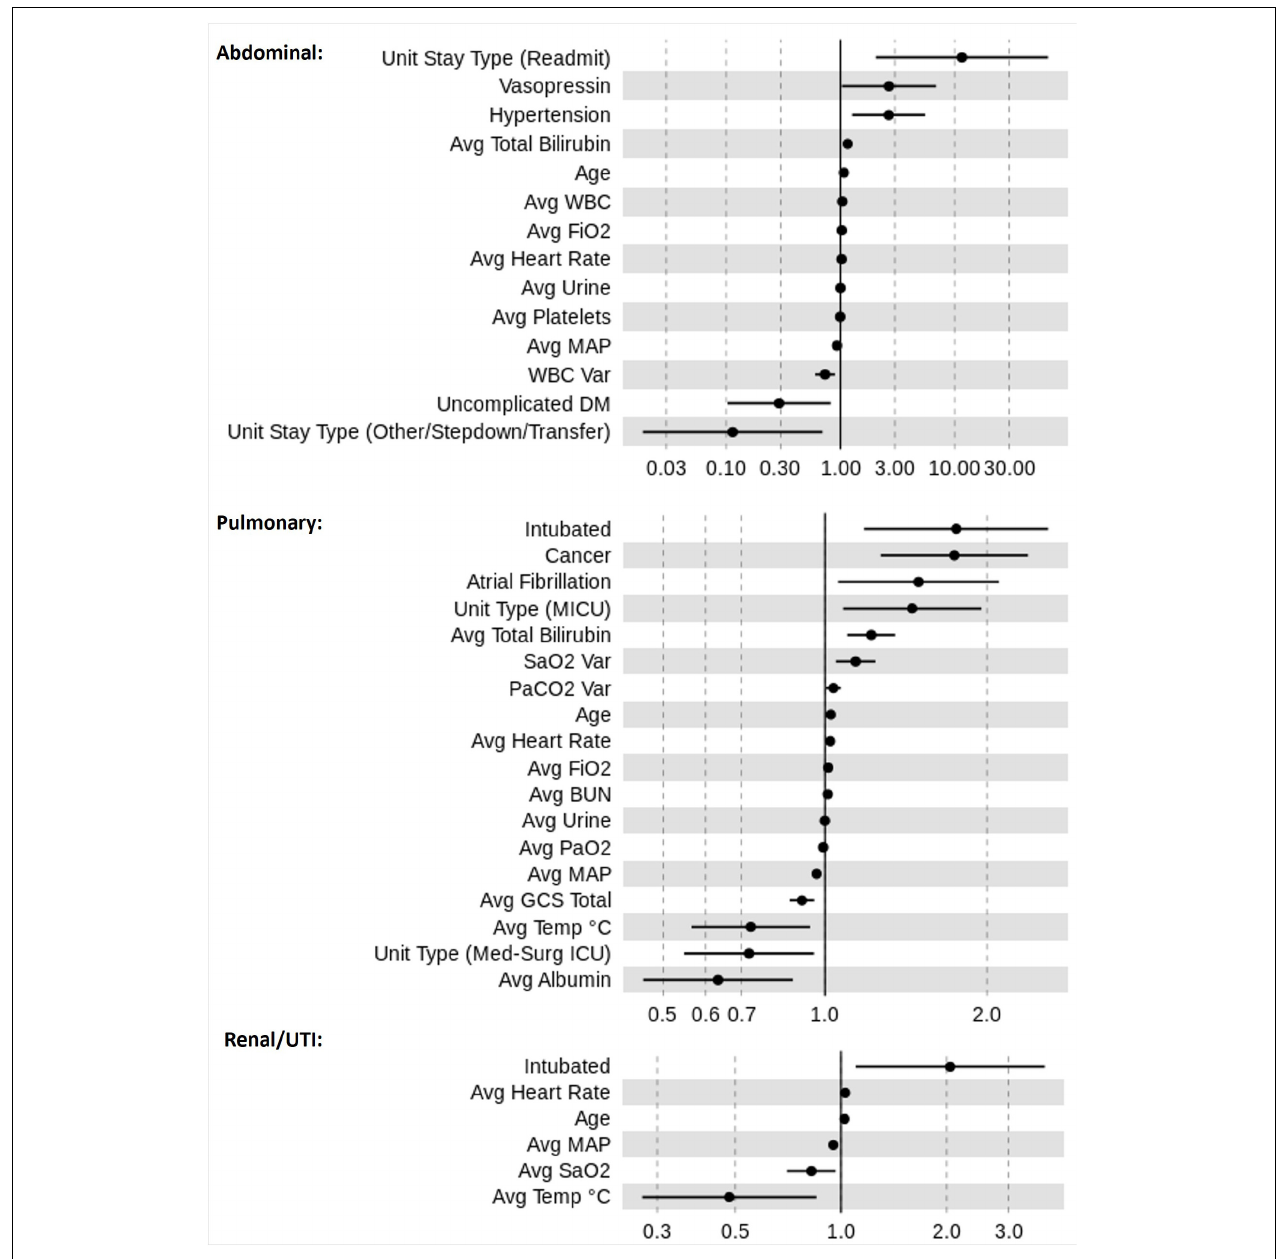
FIGURE 4 | Odds ratio (OR) estimates for LR. The figure displays the pooled ORs average (filled circles) and confidence intervals (vertical bars) for all significant features ( p < 0.05) selected by the feature selection algorithms for the sepsis groups: pulmonary, abdominal, and renal/UTI. An OR of 1 represents a baseline risk, with values < 1 indicating a reduction in risk for the outcome, and > 1 indicating an increased risk in relation to the